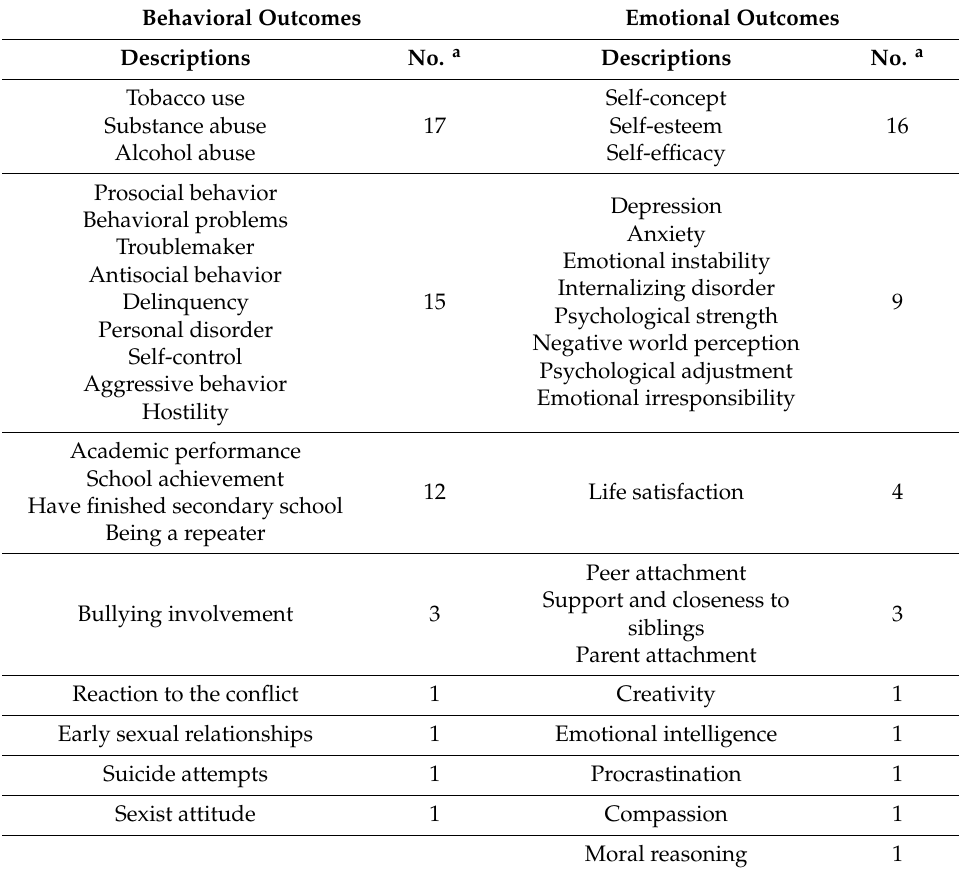
Table 3. Outcomes more frequently